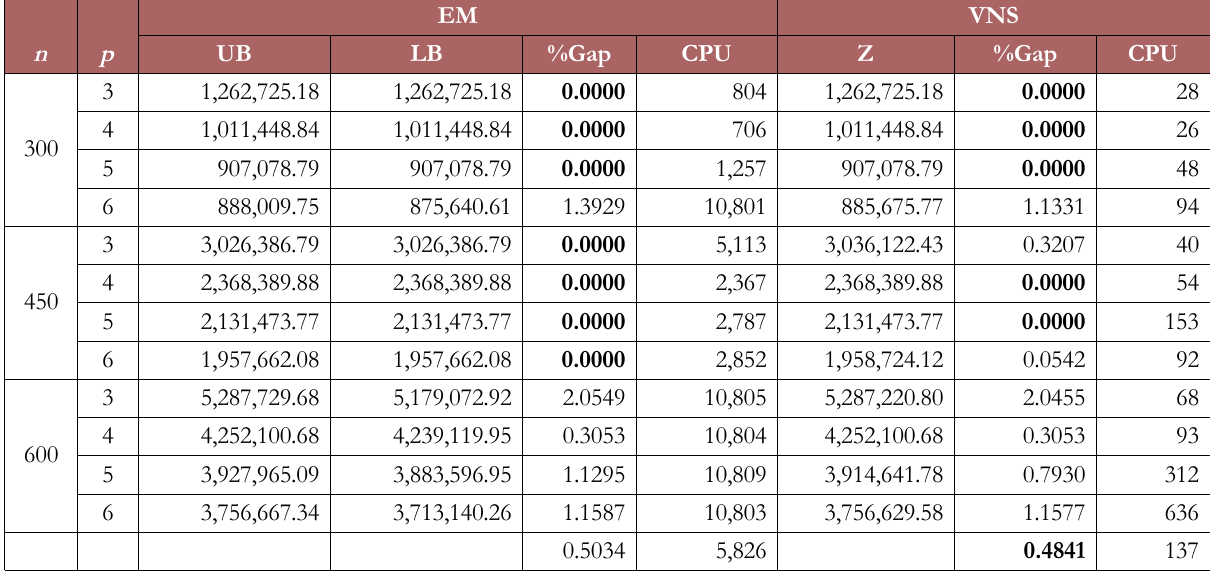
Table 1. Experimental results on the deterministic CPMP